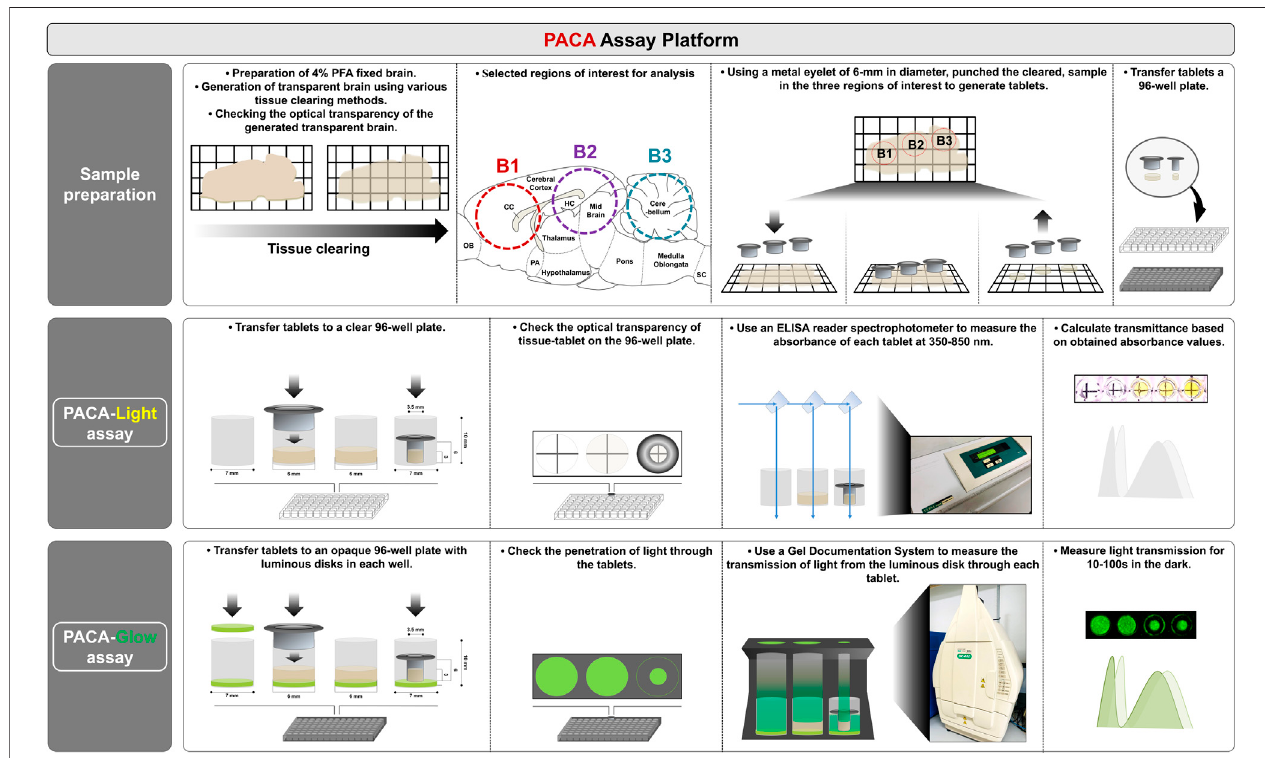
FIGURE 1 | Schematization of the Punch-based Assistance Clarity-measurement Assay (PACA) platform. 1) Sample preparation for measuring tissue transparency.Clearedorunclearedsampleswerepunchedusingmetaleyelets,either3.5or6 mmindiameter.2)PACA-Light:Eachdiscwastransferredtoanindividual well of a clear 96-well plate. An ELISA reader spectrophotometer was used to measure light absorbance along a range of wavelengths. Transmittance was analyzed based on the obtained absorbance values. 3) PACA-Glow: Each disc was transferred to an individual well of a black, opaque 96-well plate with a luminous disk (SrAl 2 O 4 :Eu 2+ ,Dy 3+ photoluminescent).Ageldocumentationsystemwasusedtoanalyzethetransmissionoflightfromtheluminousdiskthroughthedisc.Detailsofthe process applied are provided in Supplementary Figure S1